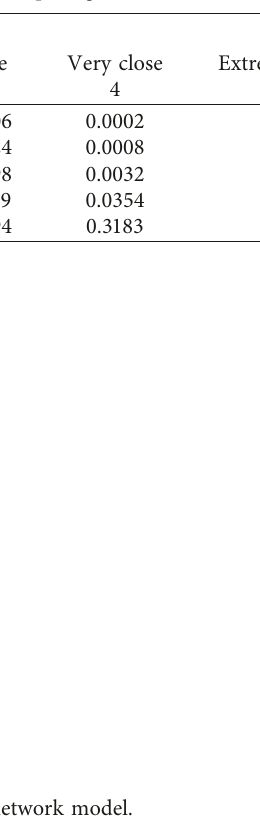
Table 3: Three-dimensional joint densities of 35 pairs of “persistence-spacing.”